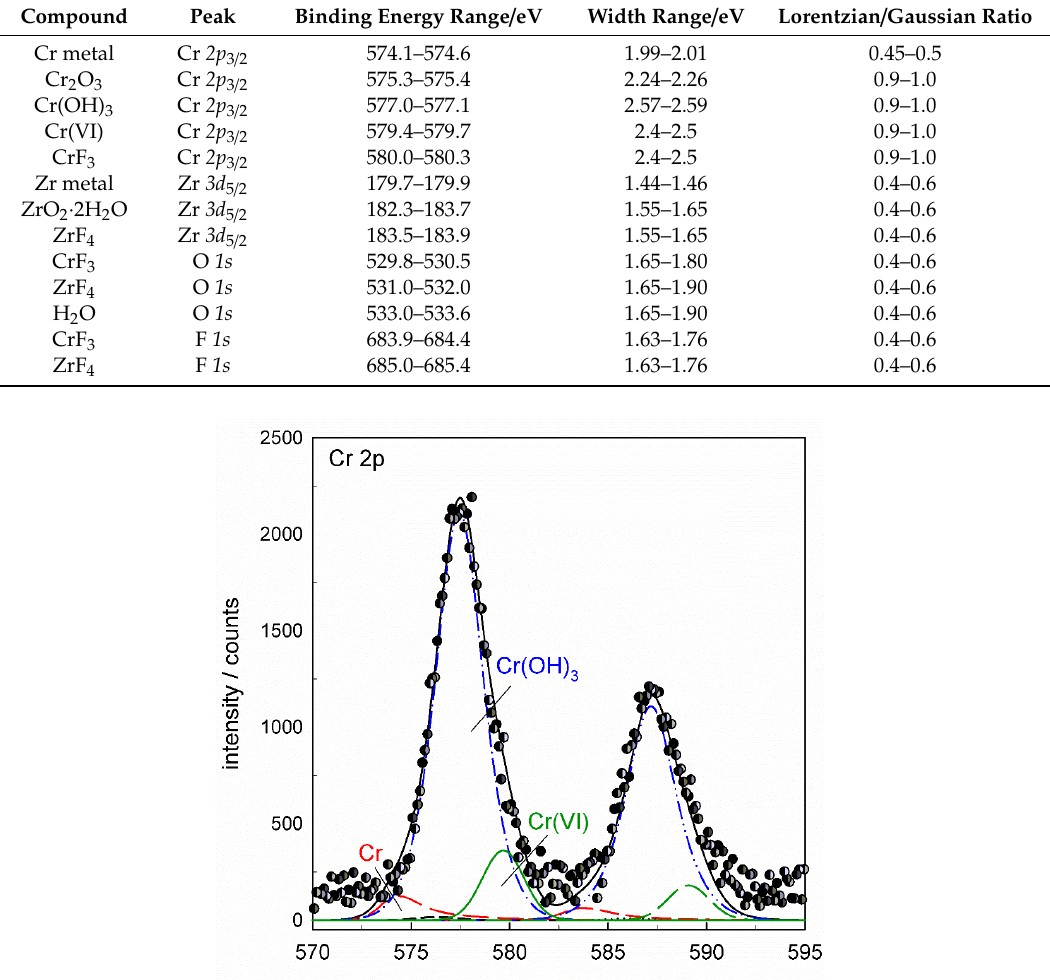
Table A3. Range of parameter of binding energy, peak width ad Lorentzian/Gaussian ratio used for deconvolution of experimental spectra (Figure 17).